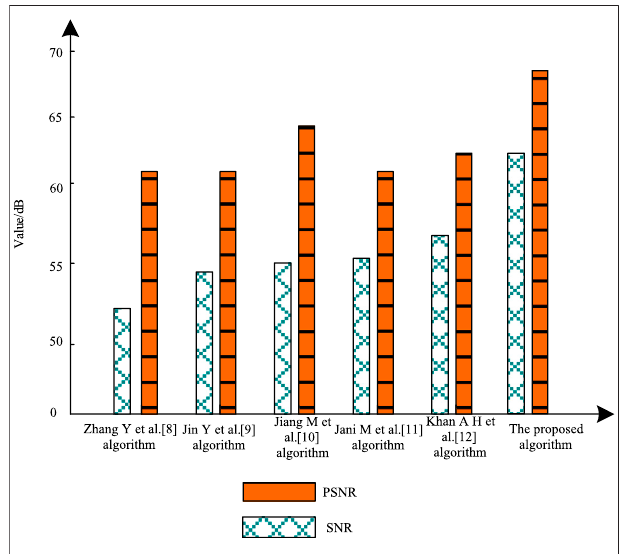
FIGURE 5 | SNR and PSNR results after speckle noise suppression.